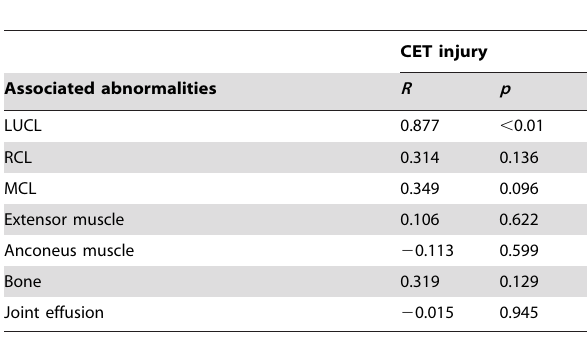
Table 5. Correlation of the CET injury with associated abnormalities of